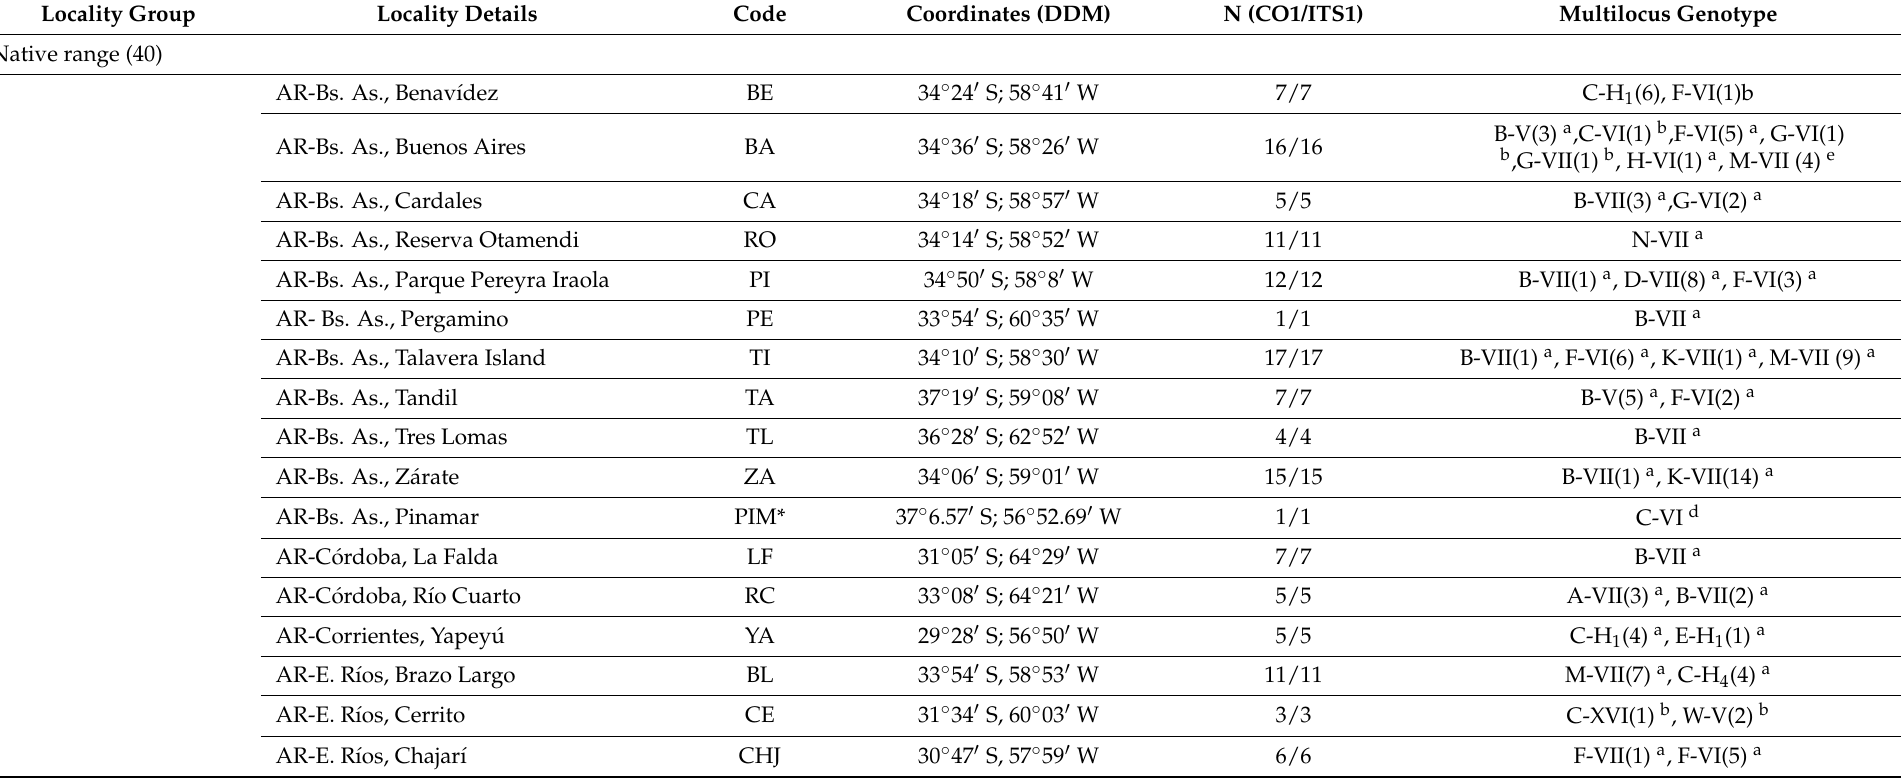
Table 1. Locality and multilocus genotype information for all native and introduced sampling locations for Naupactus cervinus . Locality groups are clusters of geographically close localities in the introduced range presumed to be the result of single introduction events: INUSCO1 and 2: Localities from Continental US area 1 (Florida and Georgia) and 2 (California); INUSI: US Insular localities from Hawaii; INSA: Localities from South America; INEU: Localities from Europe; INAUN: Localities from Australia and New Zealand and INPI: Localities from the Pacific Islands, French Polynesia. Individual locality codes are used as labels in Figure 1, and those followed by an asterisk (*) are newly included in this study. N: indicates the number of sequences for each gene region from that locality. Combined genotype codes list COI and ITS1 variants in that order, all ITS1 genotypes are roman numerals with the exception of four heterozygote genotypes labeled H1-4. Heterozygote genotypes are 1: VI-VIII, 2: I-XIX, 3: XIII-XII, and 4: VI-XVIII. When localities harbor different multilocus genotypes, numbers in parentheses beside genotype designations indicate the number of weevils that carry each genotype in that locality. The table footnote describes superscript letters that accompany each multilocus genotype indicating the origin of those sequences (obtained for this study or from previous